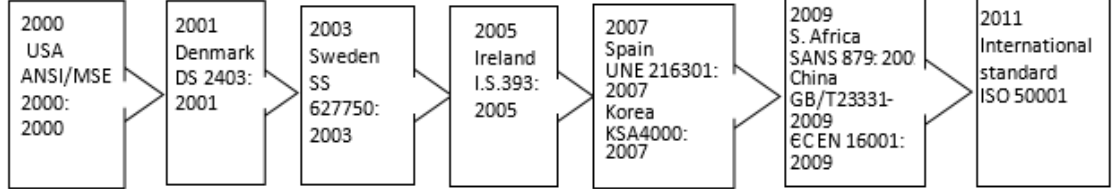
Fig. 2: Evolution of standards for energy management, energy auditing and energy efficiency